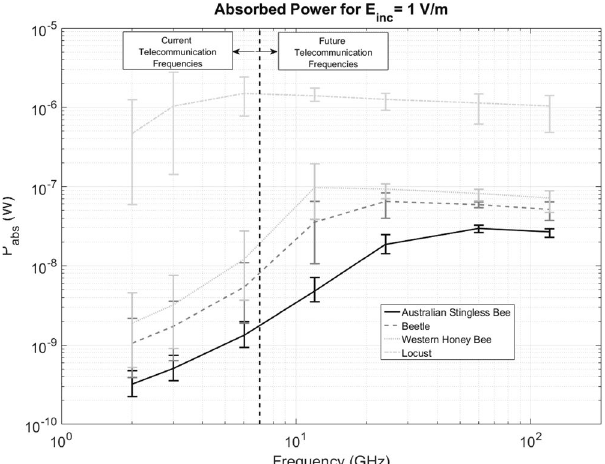
Figure 5. P abs for an incident field strength of 1 V/m as a function of frequency for all studied insects. The markers indicate the average over all twelve plane waves at each of the simulated frequencies, while the whiskers indicate the minimal and maximal Pabs values obtained during the